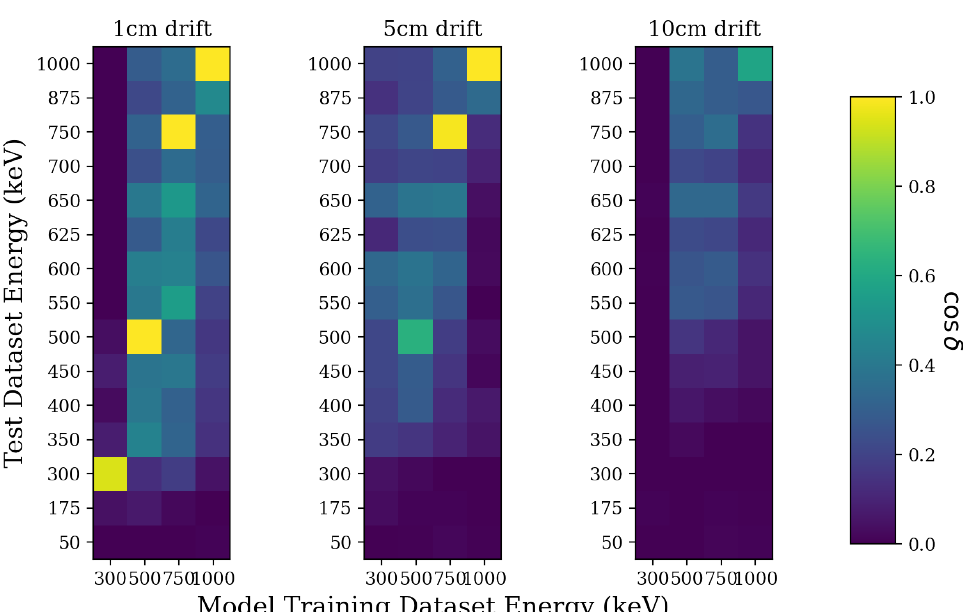
Figure 5. Error for models trained on one energy and drift length and tested on energies from both the data set and outside it. Each pixel in the grid is the median of the error cos δ for the 5000 tracks in the test data set.